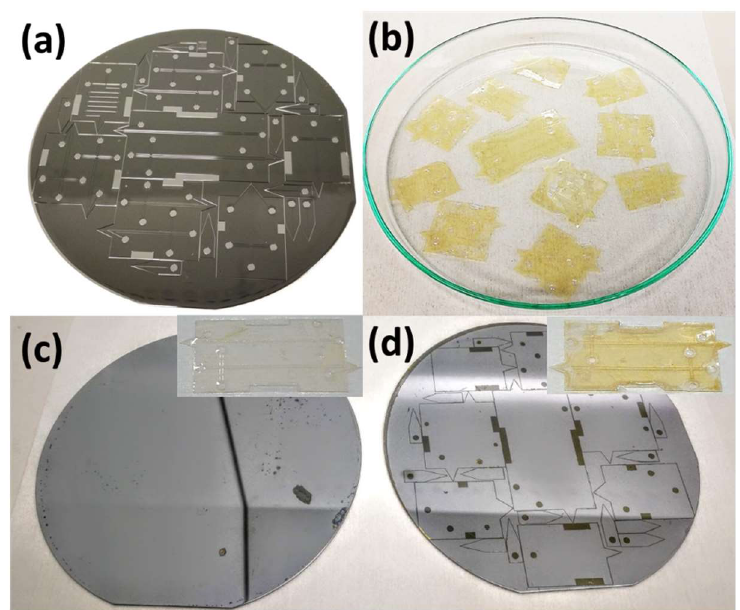
Figure 3. ( a ) Multilayer SU-8 devices fabricated on AZ 15nXT on silicon wafer before release ( b ) Free-standing SU-8 ESI chips after releasing from the substrate ( c ) Silicon wafer after releasing by wet Technistrip assisted release (Method 1 or 2), which leaves very little residue and can be reused with simple cleaning steps ( d ) silicon wafer after releasing from thermal assisted Technistrip release (Method 3), which leaves more residues. Insert shows the released chips. Residual AZ 15nXT from chips can be removed by incubating for more time in Technistrip.